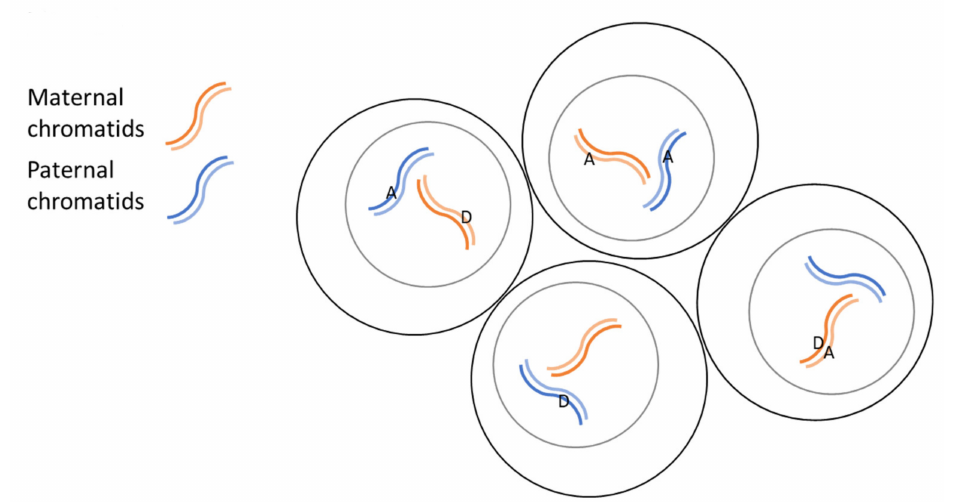
Figure 8. Some examples of possible genome alterations after simultaneous treatment with two donors. One donor contains the A mutation and the other donor, the D mutation. The A and D mutations are shown randomly incorporated into di ff erent sites of duplicated homologous chromosomes. Note that in each cell, there are 4 sites to which A and D mutations can be incorporated. Thus, many other combinations of A and D integration into a single cell are also possible, as are di ff erent combination of these cells in a single blastocyst or mouse. However, in our experiments shown in Figure 7, most of the blastocysts and mice contained either the A or the D alteration. Only one pair of paternal (blue) and maternal (red) chromosomes out of the total 20 chromosomes in a mouse cell is shown in this